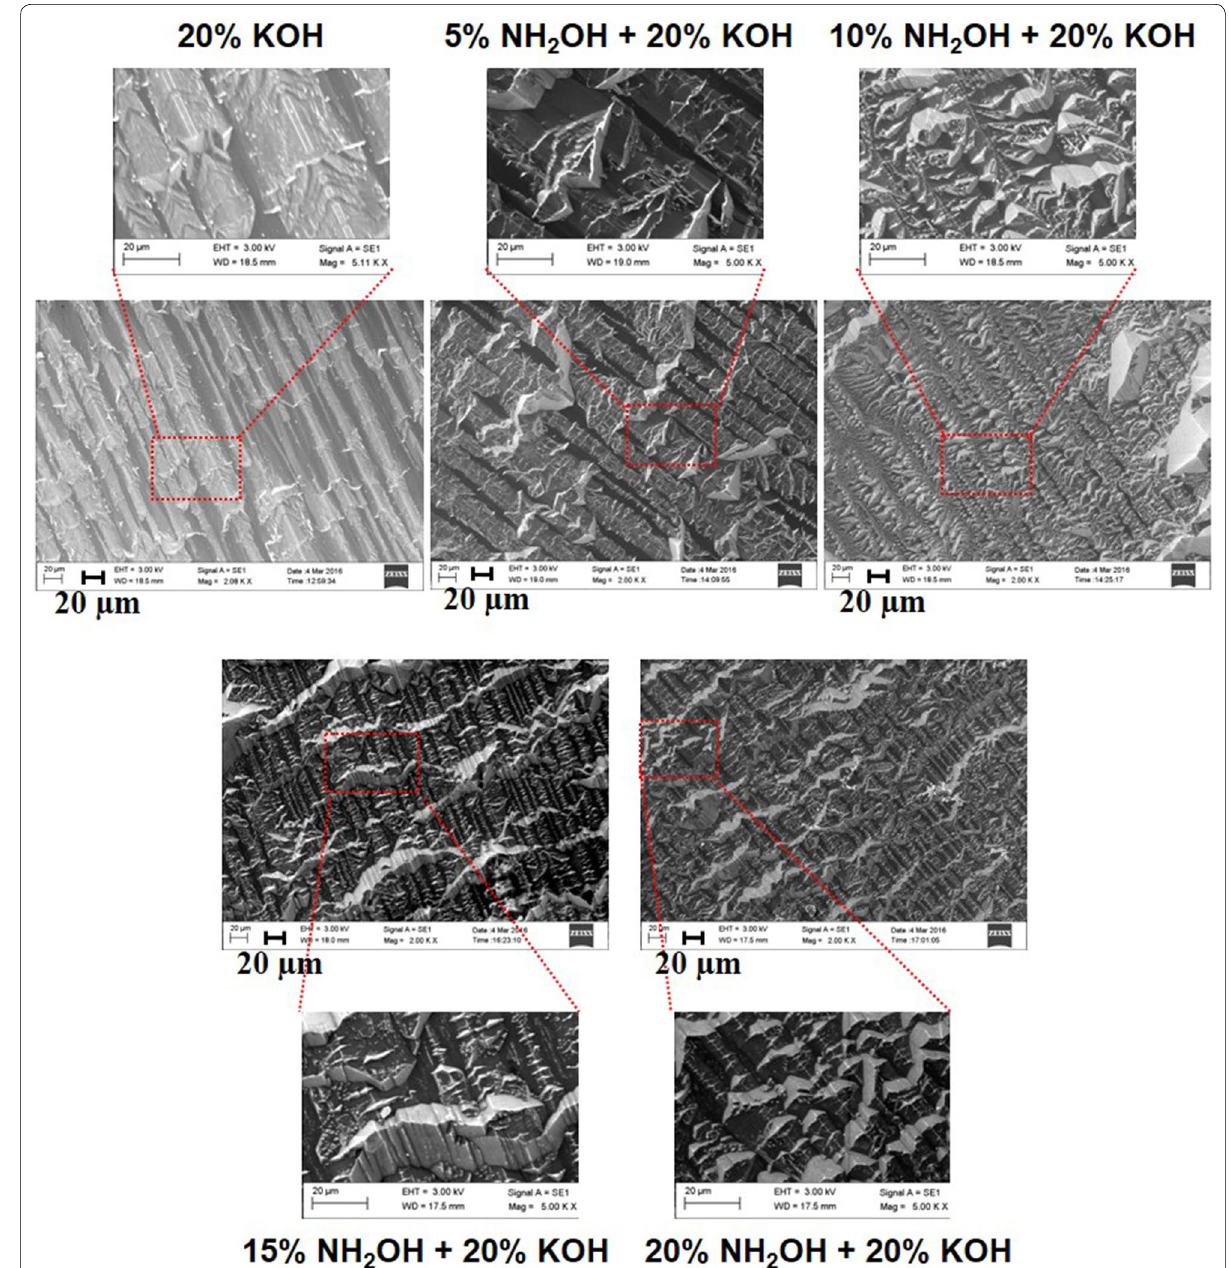
Fig. 5 SEM photographs showing the surface morphology of the samples etched in 20 wt% KOH solution without and with addition of NH 2 OH at 75